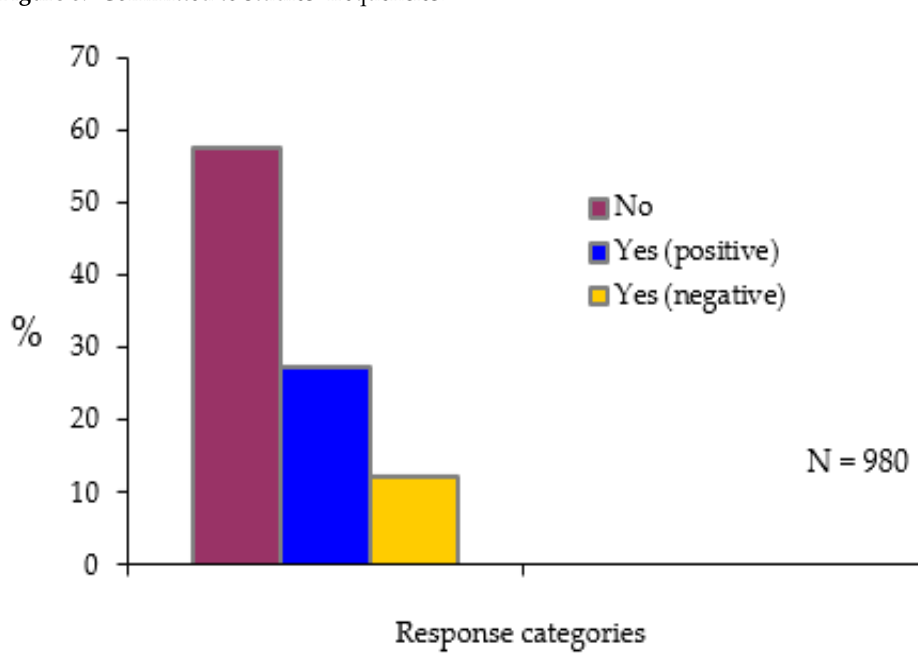
Figure 8. ‘Committed to studies’ frequencies.